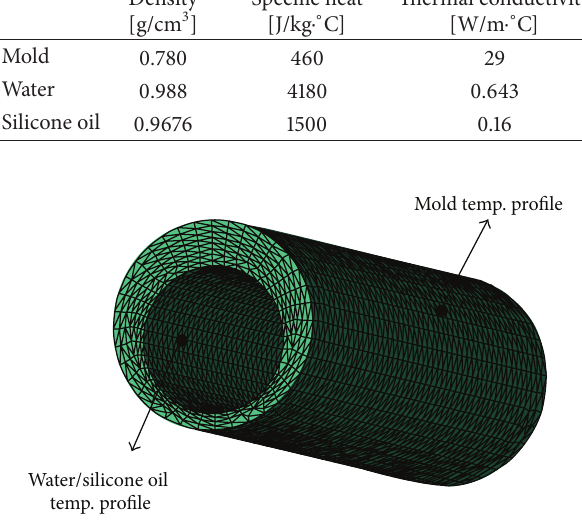
Figure 6: Finite element model for prediction of void